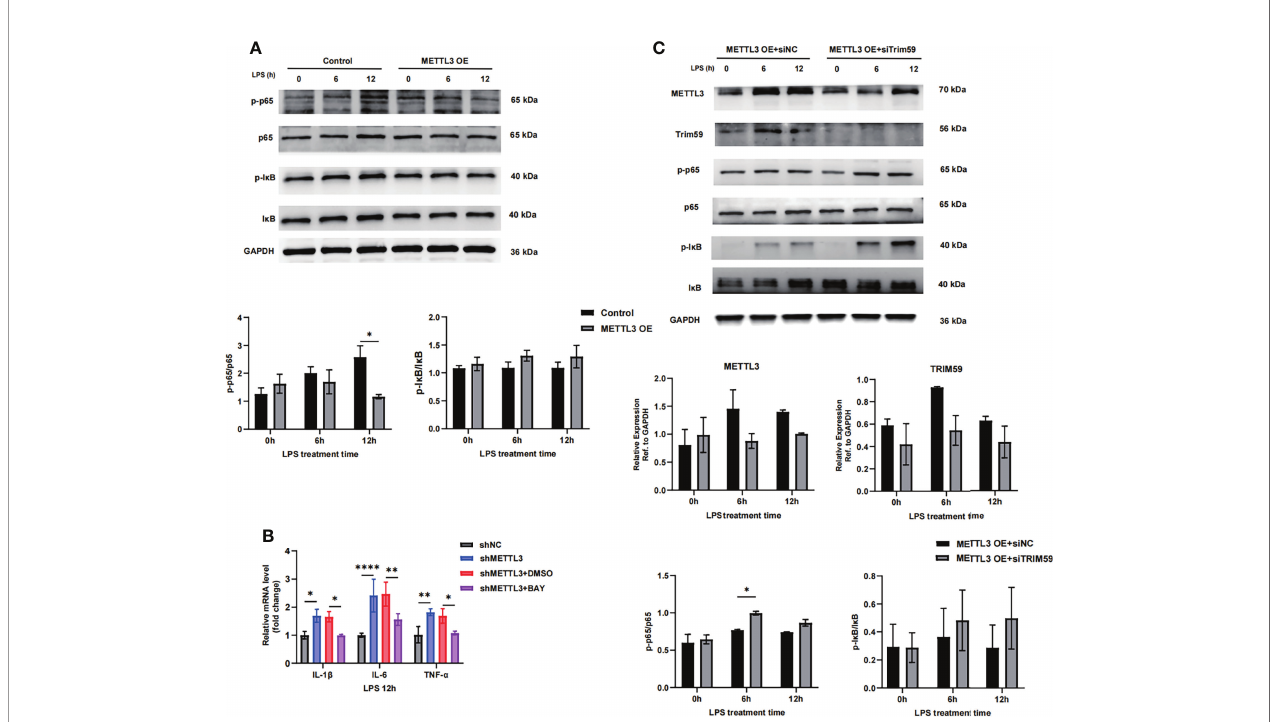
FIGURE 6 | METTL3 inhibits endothelial injury in sepsis-induced ARDS through Trim59-associated NF- k B inactivation. (A, C) Immunoblot showing p65 and I k B phosphorylation in HULEC-5a cells treated with or without METTL3 overexpression (A) and METTL3-overexpressing HULEC-5a cells with or without Trim59 siRNA (C) . (B) RT-qPCR analysis showing in fl ammatory cytokine and endothelial functional marker mRNA expression in METTL3-overexpressing HULEC-5a cells treated with or without the NF- k B inhibitor BAY. All data are expressed as the mean ± SD of three independent experiments. * p < 0.05; ** p < 0.01; **** p <